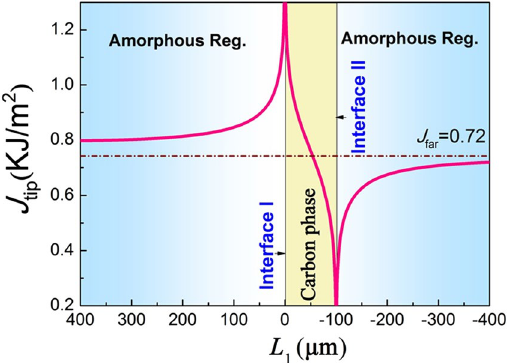
Figure 9. The crack driving force ( J tip ) as a function of distance ( L 1 ) against the first interface between the carbon phase and amorphous matrix.